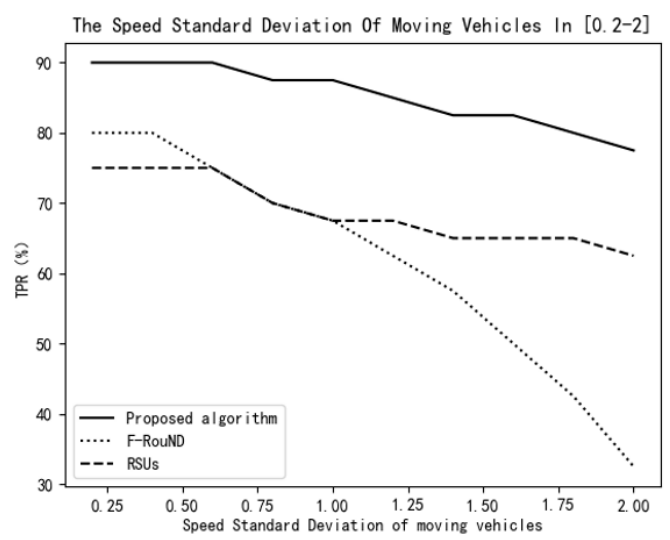
Figure 13. Variation of TPR vs. speed standard deviation of moving vehicles.